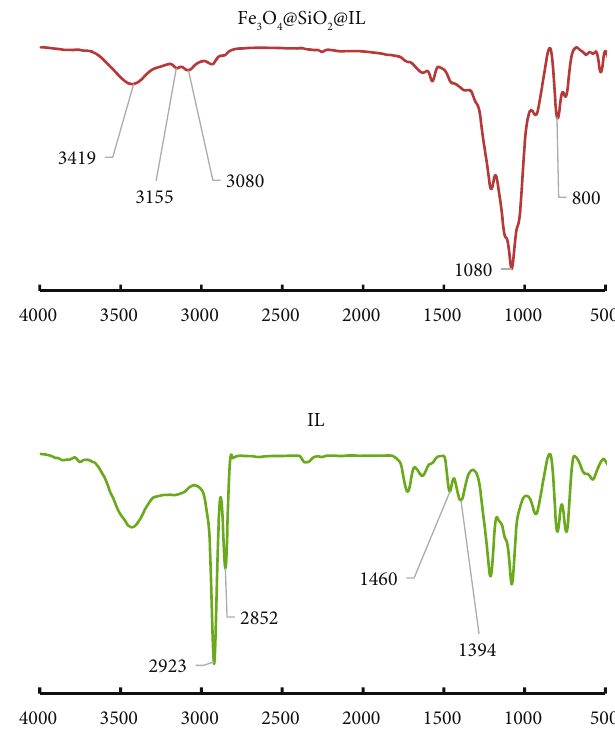
Figure 5: FTIR of IL and Fe